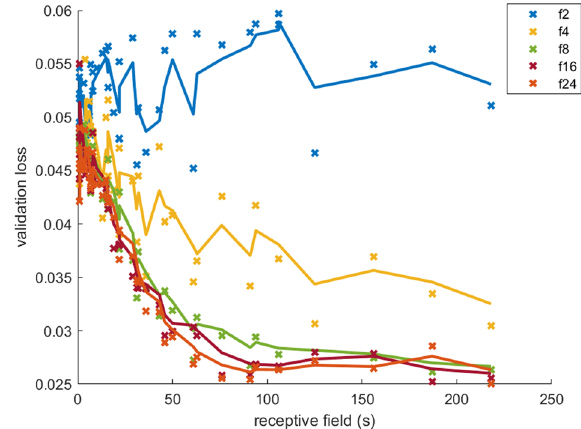
Fig. 2 Model validation performance across different receptive fi elds (determined by kernel size and dilation depth) grouped by the number of fi lters in the convolutional layers (f#). Exponential weighted moving average fi ts were plotted for visualization purposes. The optimal model hyperparameters were 24 fi lters, 8 kernel sizes, and 5 dilations. Two fi lters per layer were insuf fi cient for learning the transformation function.